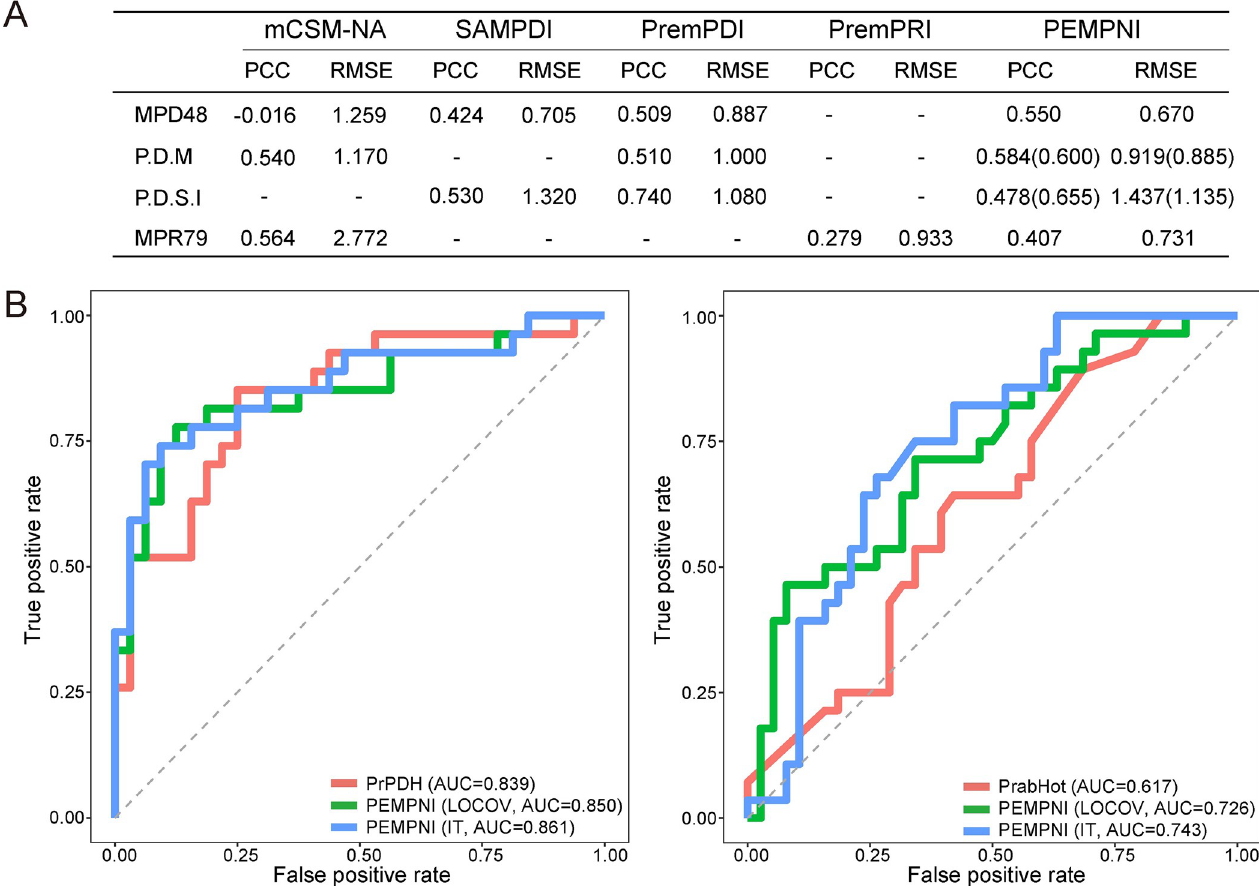
Fig 6. Comparison of PEMPNI and existing methods. (A) PEMPNI versus other methods for regression tasks. The performance in parentheses was generated from our algorithm trained by the datasets of PremPDI. (B) PEMPNI versus other methods for classification tasks. integrative algorithm outperformed PrPDH in terms of AUC (0.875 versus 0.792). The trp